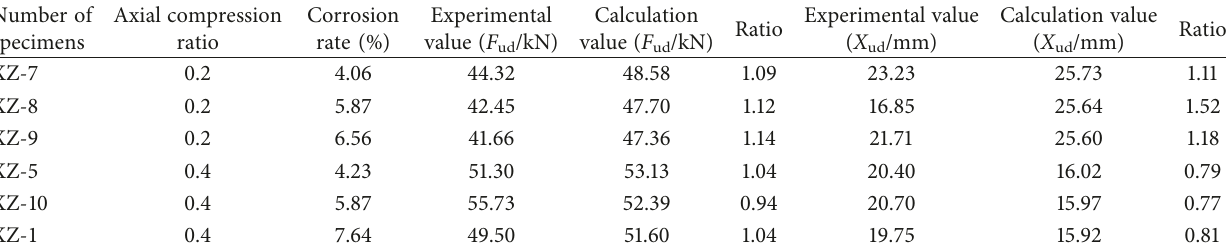
Figure 7: Corrosion test device diagram. Table 6: The comparison between theoretical value and experimental value.